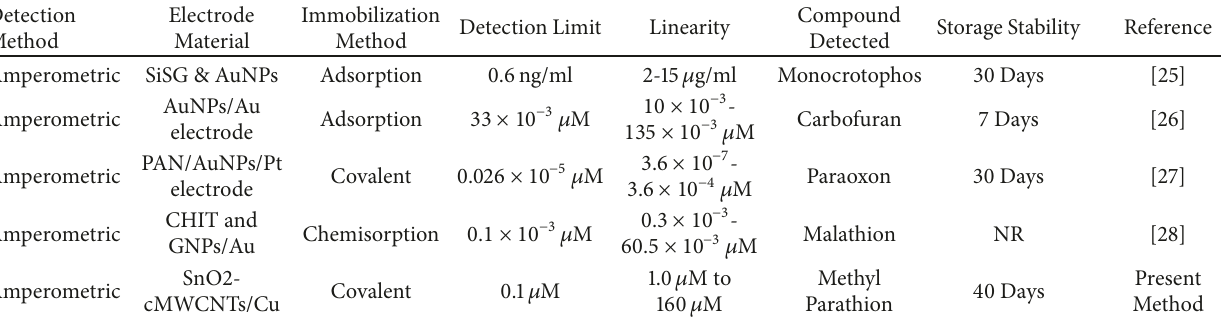
Table 3: Comparison of present method with earlier reported